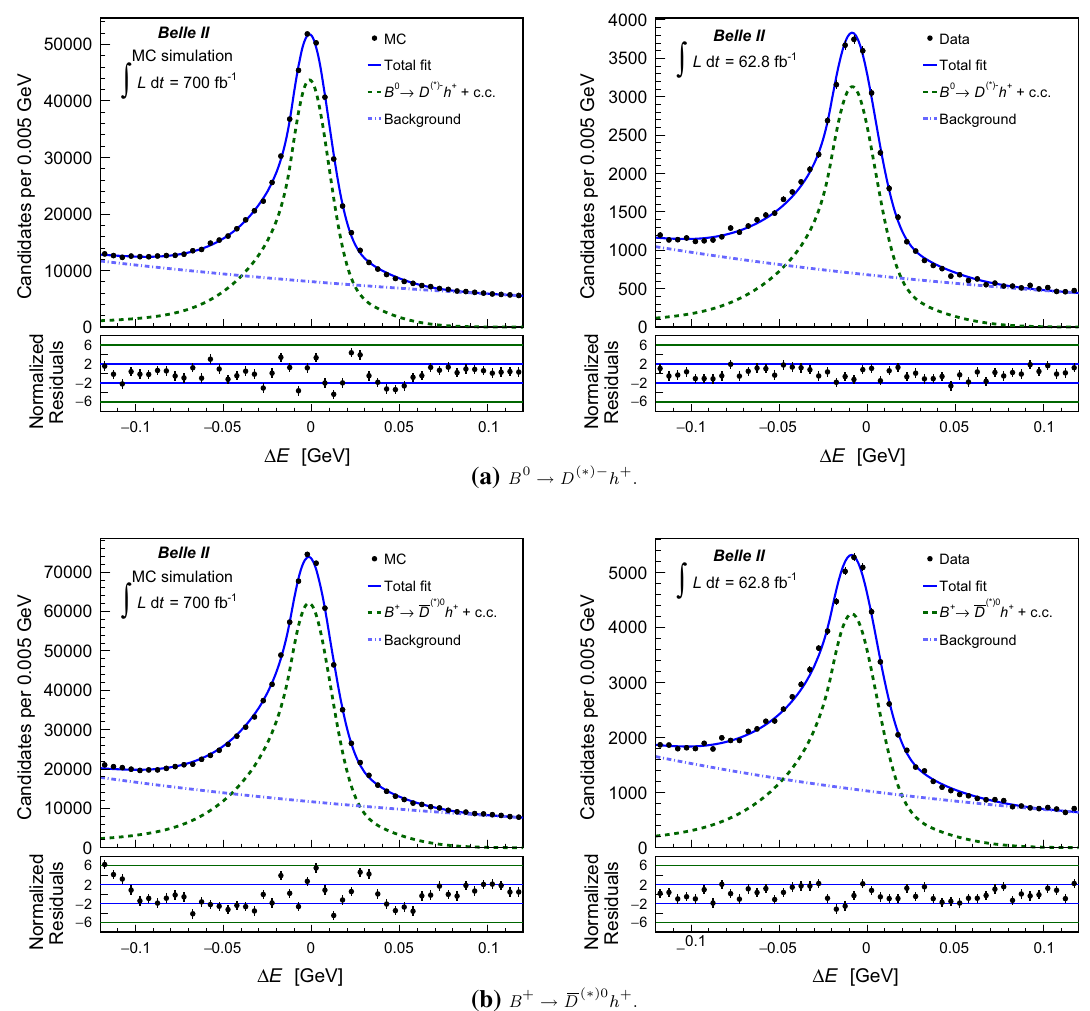
Fig. 6 Distributions of Δ E for (top) neutral and (bottom) charged B → D restricted to M bc > 5 . 27GeV/ c 2 . The fit projection of the maximum likelihood fit is overlaid Table 4 Summary of yields and yields per integrated luminosity obtained from the fit to − 1 MC simulation (700fb ) and − 1 data (62.8fb ). The uncertainties are only